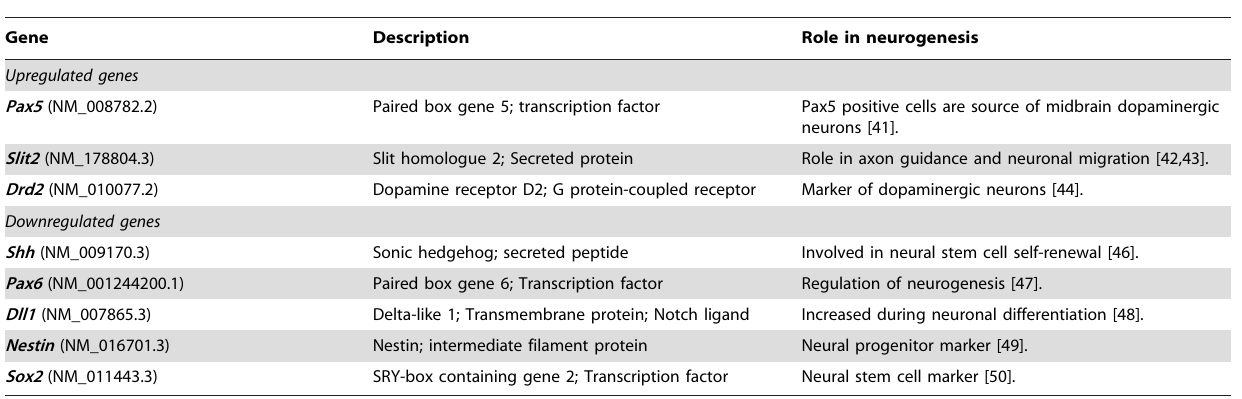
Table 2. Description of selected genes modulated by